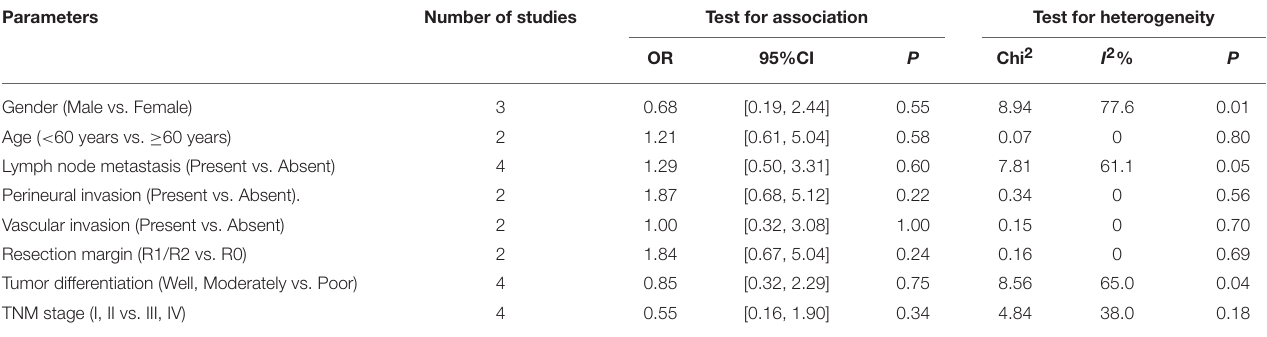
TABLE 4 | The relationship between PD-L1 in ICs and the clinicopathological features.